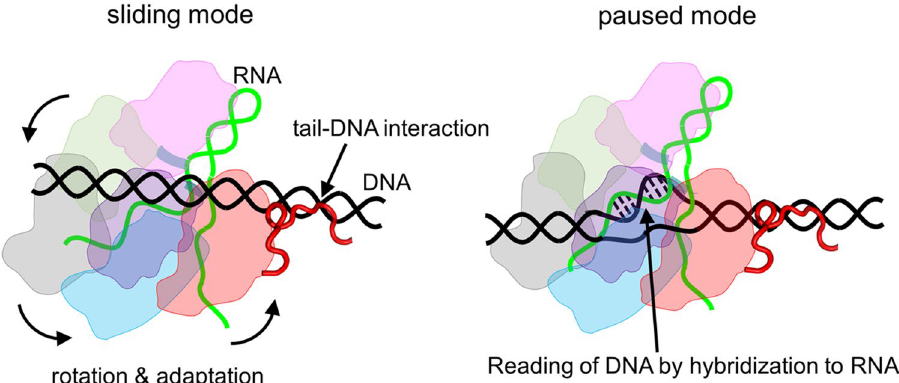
Figure 5. Schematic model of sliding and paused modes of the Cas9 hybrid with tail. Cas9 is composed of REC1 (light pink), REC2 (light green), REC3 (light grey), RuvC (light blue), HNH (light purple), and PI (light red) domains. Green and black strands denote gRNA and DNA, respectively. In sliding mode, the tail (red), introduced into Cas9, interacts with DNA, triggering the rotation of the Cas9 structure. This conformational change causes the adaptation of the complex structure, facilitating the sliding dynamics along DNA. In paused mode, Cas9 induces unwinding of DNA, and subsequent partial hybridization between DNA and gRNA strands occurs. This action enables Cas9 to read the sequence of